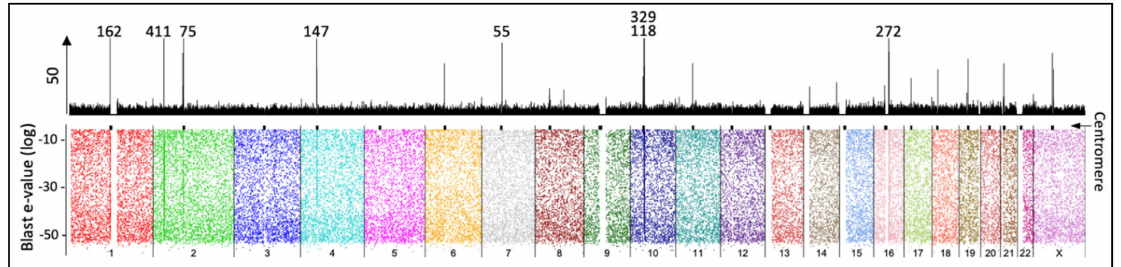
Figure 7. Overall map of 50,732 pooled read-integrations in the human genome. The top panel Scheme 20. bins). The vertical axis is cut to 50 to highlight differences. The numbers mark positions with higher than 50 counts. The bottom panel shows the integrations (dots) in all chromosomes distributed by blast e-value to show the lack of mapping bias. Centromeres coordinates (hg19) are marked with a black spot above. Note higher counts close to